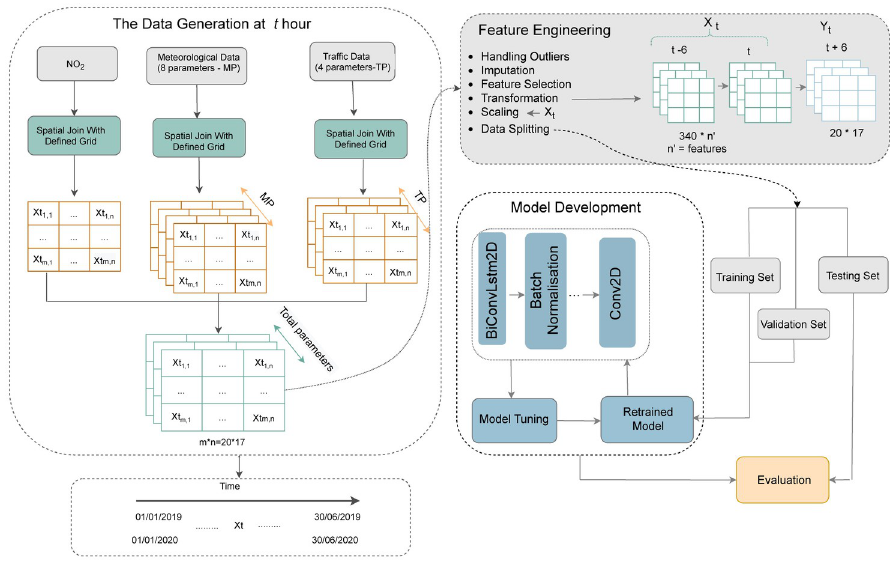
Fig 6. The detailed workflow of the